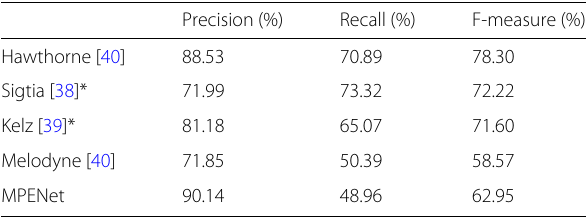
Table 8 Frame-level AMT results using 60 full-length music